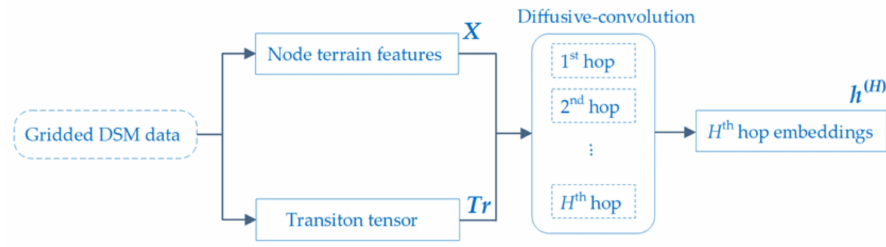
Figure 5. Diffusive convolutional